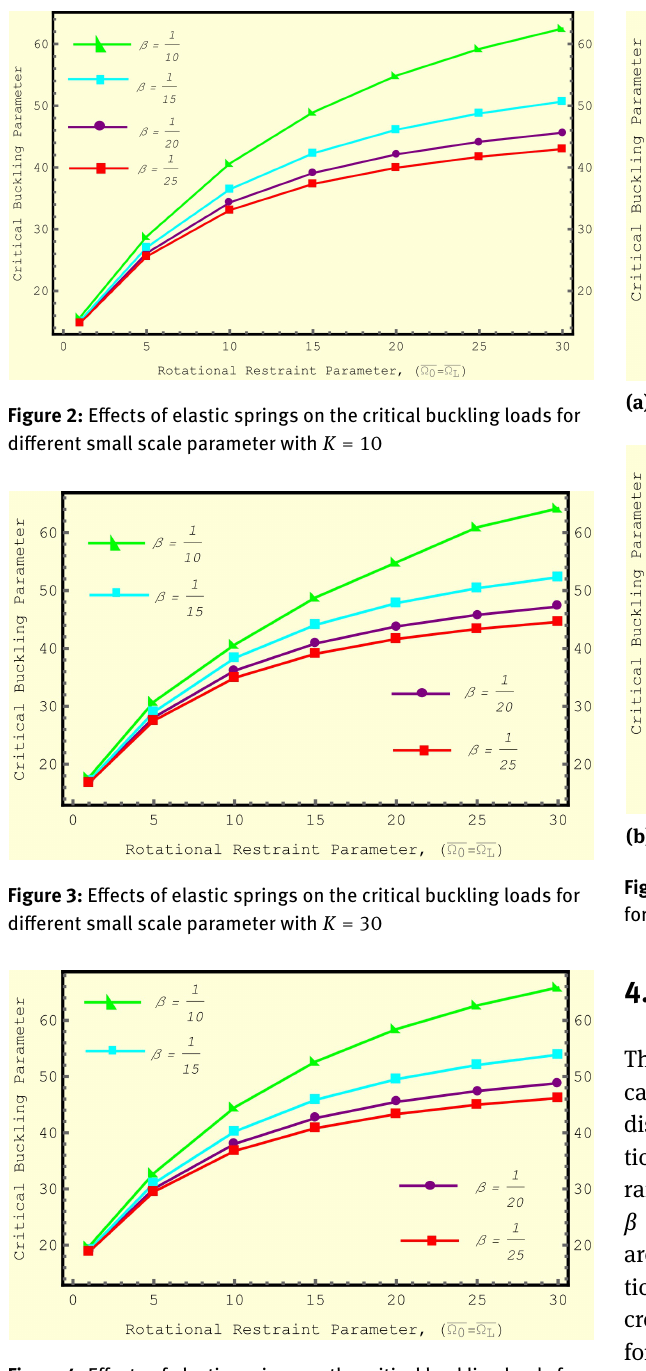
increasing value of length scale parameter ( β ) leads to an increase the critical buckling load.